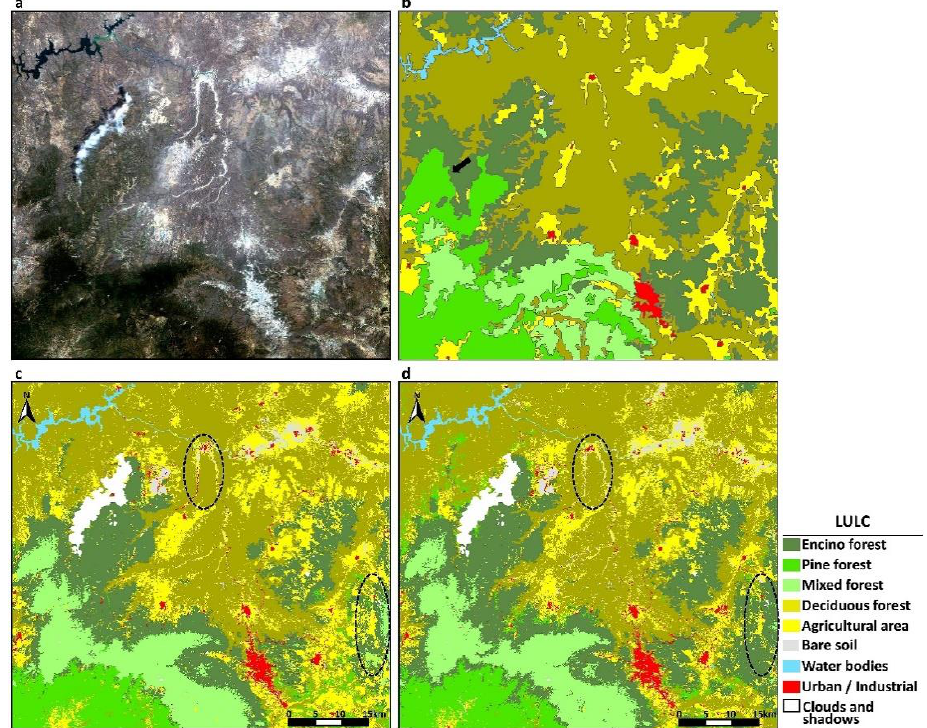
Figure 11. Classifications applied to the test date (2011). ( a ) RGB True-color composition, ( b ) LULC Official cartography of the test date study area (INEGI, 2015), ( c ) Conventional classification image applying own training polygons (2011), and ( d ) Classification image through change detection for 2011, applying training polygons of the base date (2016).